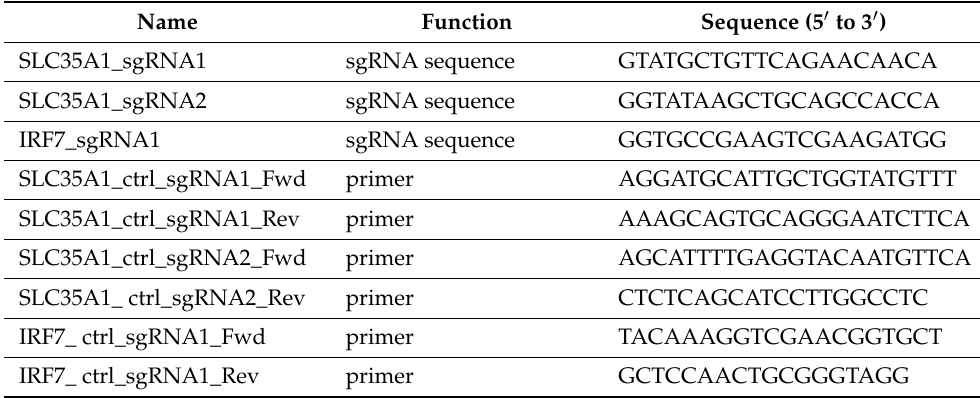
Table 1. sgRNA sequences and control primers used to confirm cutting